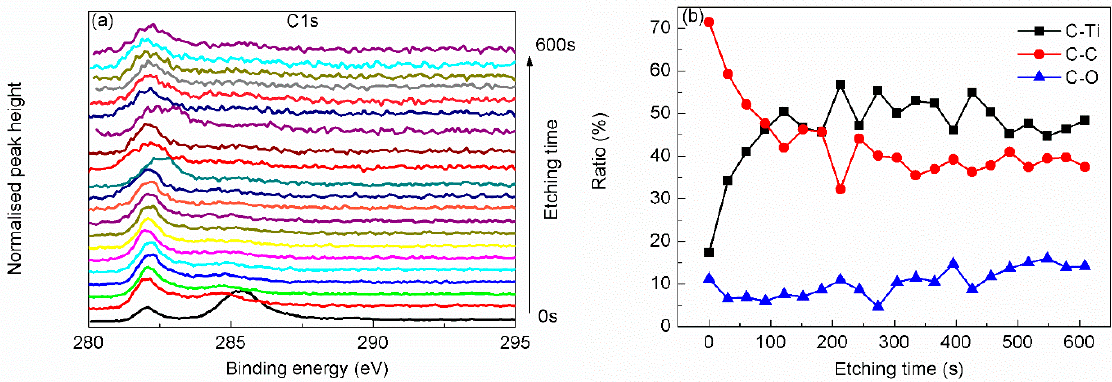
Figure 4. Narrow scanning depth profile ( a ) and state ratio depth profile ( b ) of C